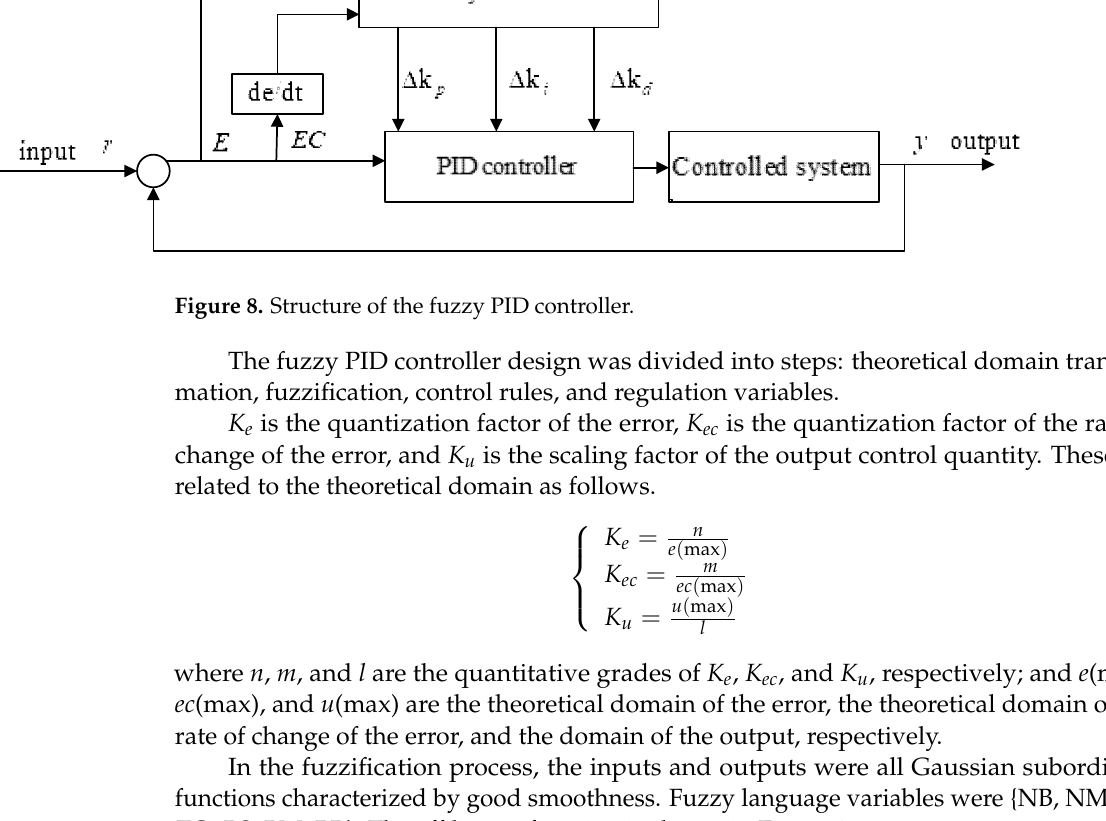
NB Table 2. The fuzzy control rules of integral coefficient. E